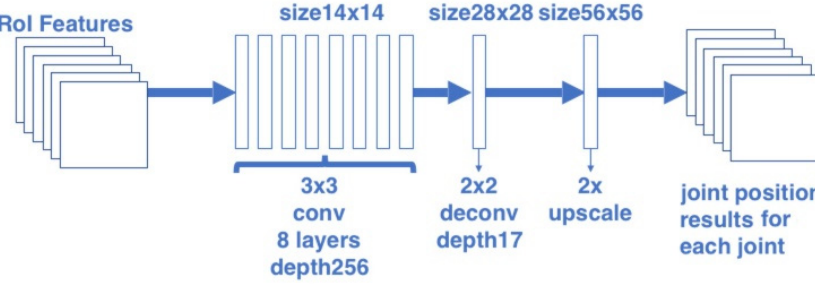
Figure 4. Architecture of the joint position estimation branch.